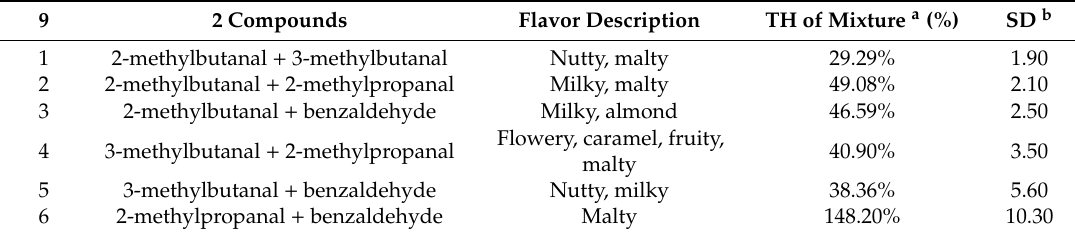
Table 2. Threshold values of mixtures of compounds in the ratios of their individual thresholds (TH) and the corresponding flavor